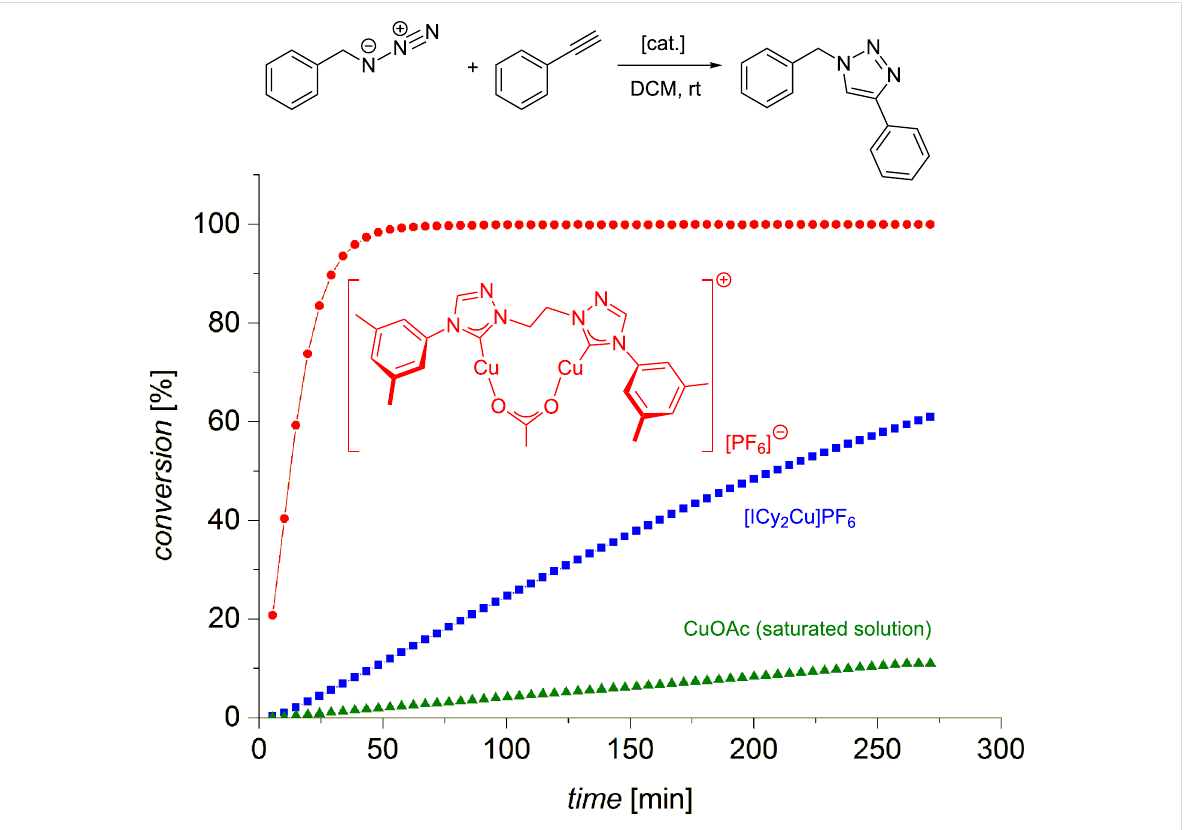
Scheme 25: Homogeneous CuAAC catalysis with a bistriazolylidene dicopper complex (0.5 mol %) and comparison with [ICy 2 Cu]PF 6 (1.0 mol %) and CuOAc (saturated solution)